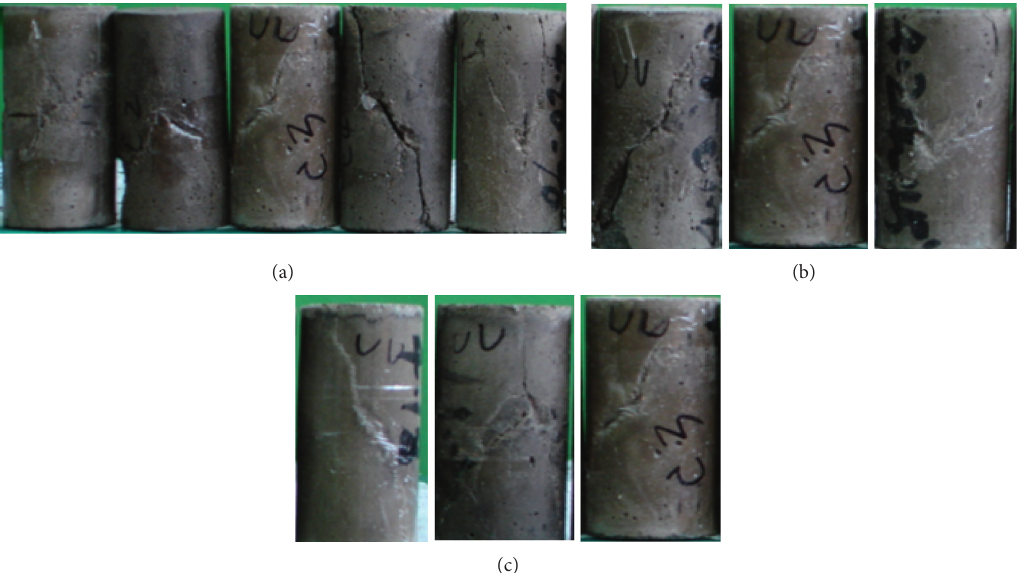
Figure 14: Failure forms of cracked specimens under axial unloading and radial unloading conditions. (a) Effect of crack inclination angle: 0 ° , 30 ° , 45 ° , 60 ° , 90 ° , from left to right. (b) Effect of confining pressure unloading rate: 0.1MPa/s, 0.5MPa/s, 1.0MPa/s, from left to right. (c) Effect of initial confining pressure: 8MPa, 10 MPa, 15MPa, from left to